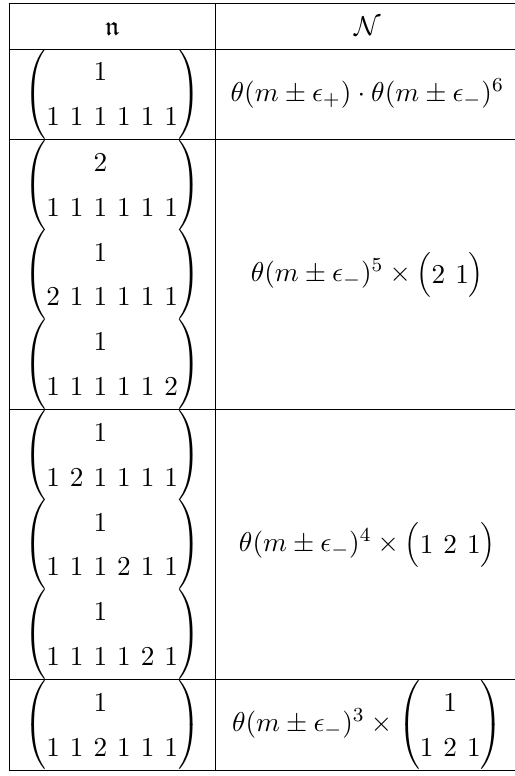
Table 7 . Elliptic genera of E 7